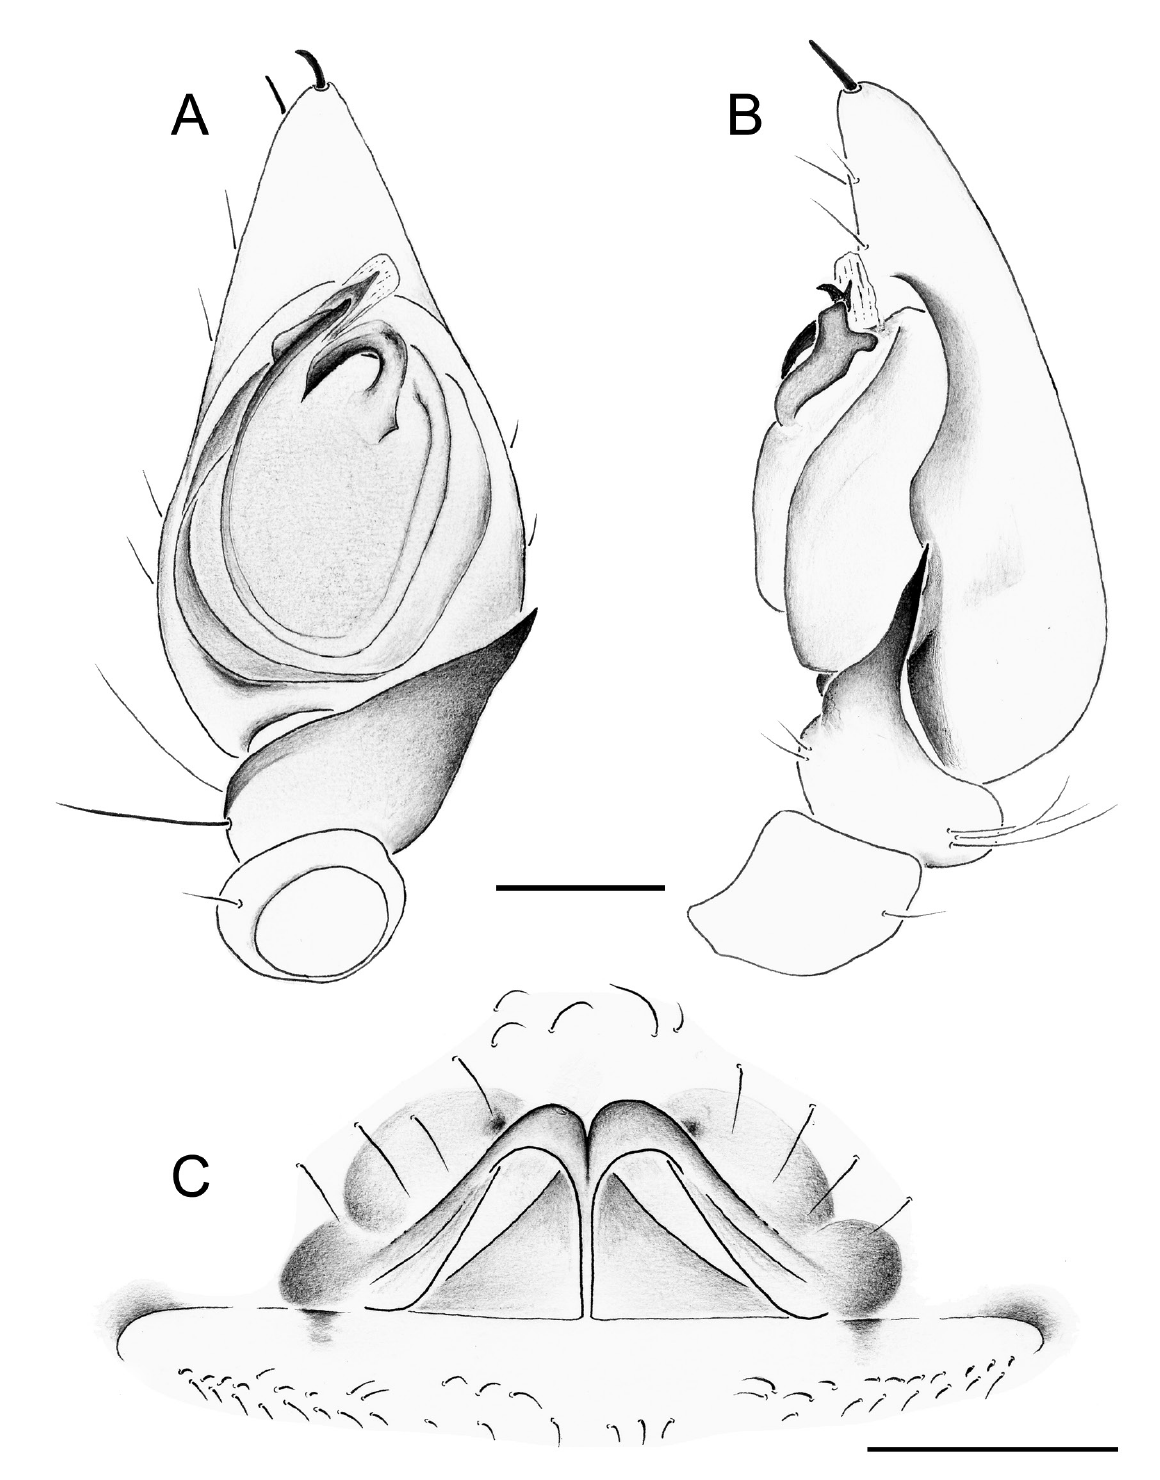
Fig. 3. Acanthinozodium crateriferum sp. nov. A–B . Holotype ♂. C . Paratype ♀. A . Male palp, ventral view. B . Idem, retrolateral view. C . Epigyne, ventral view. Scale bars = 0.2